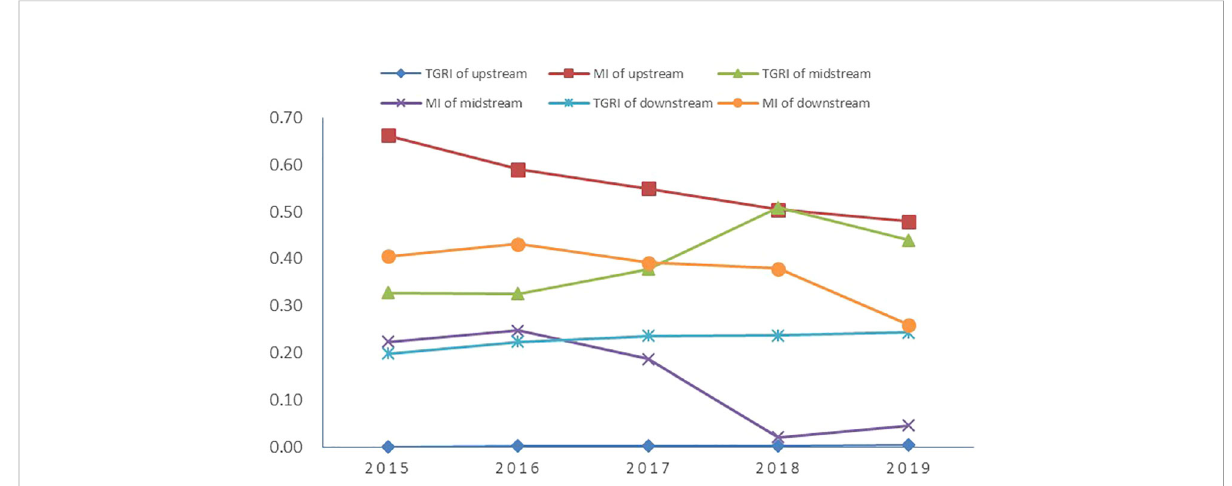
FIGURE 9 Development trends of TRGI and MI for each link of the industry chain after adjustment,